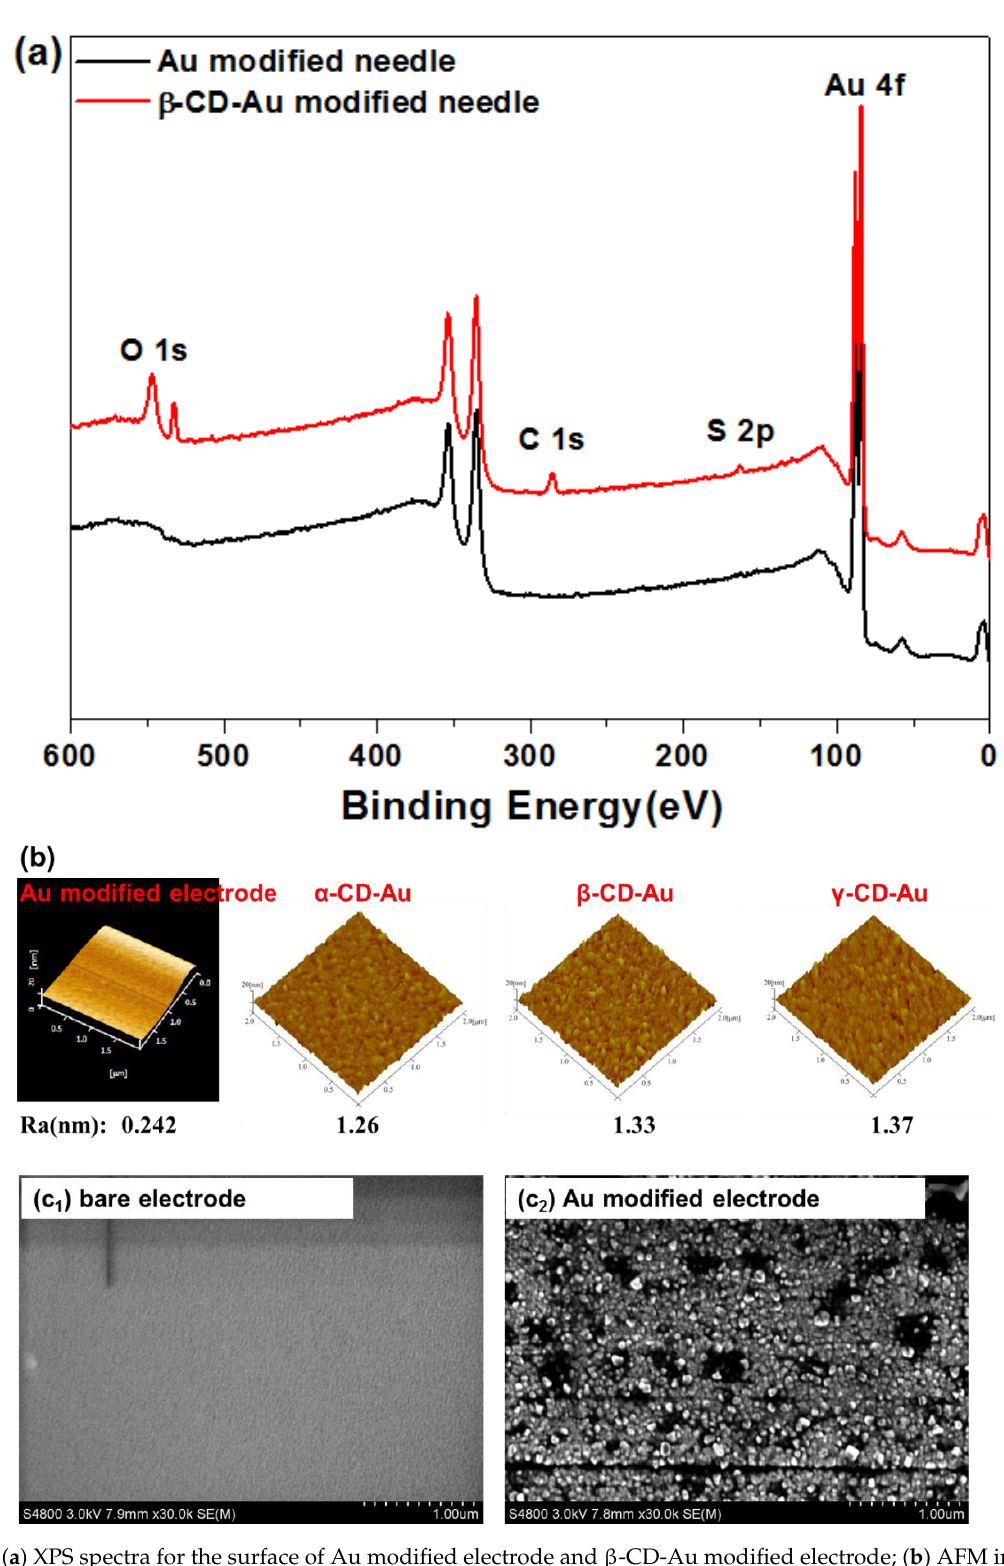
Figure 3. ( a ) X PS spectra for the surface of Au modified electrode and β -CD-Au modified electrode; ( b ) AFM images and roughness coefficients (Ra) of different modified surfaces; ( c 1 ) SEM images for bare electrode, and (c 2 ) Au modified electrode. Table 1. Elemental analysis on the surface of Au modified electrode and β -CD-Au modified electrode.